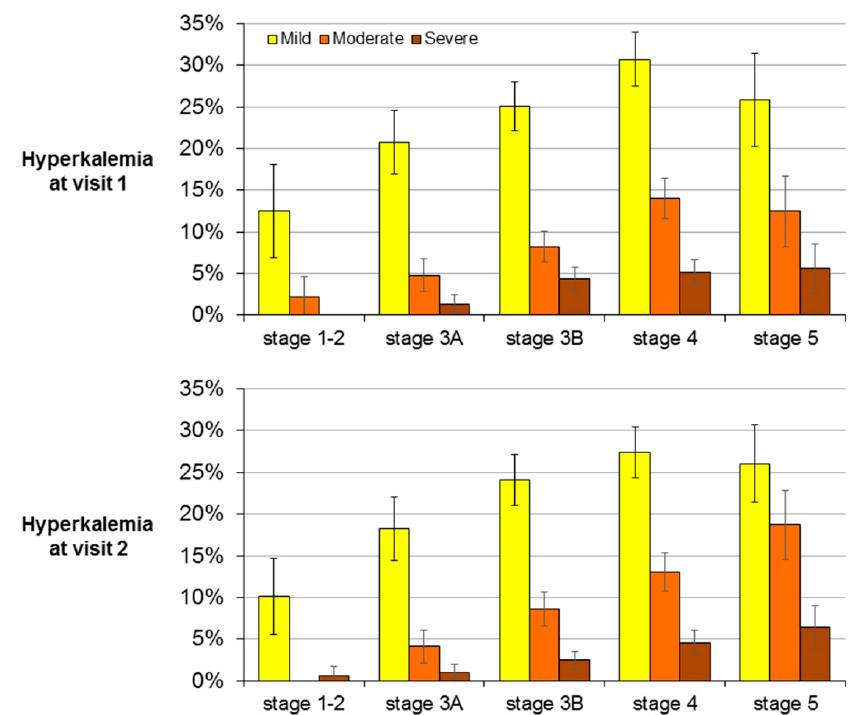
Figure 2. Prevalence (% and 95% CI) of mild, moderate and severe hyperkalaemia by CKD stage at the two study visits. Mild: serum K 5.0–5.4 mEq/L; Moderate: 5.5–5.9 mEq/L; Severe: ≥ 6.0 mEq/L. Mean sK did not differ in the two visits (4.81 ± 0.62 and 4.80 ± 0.59 mEq/L, respectively).